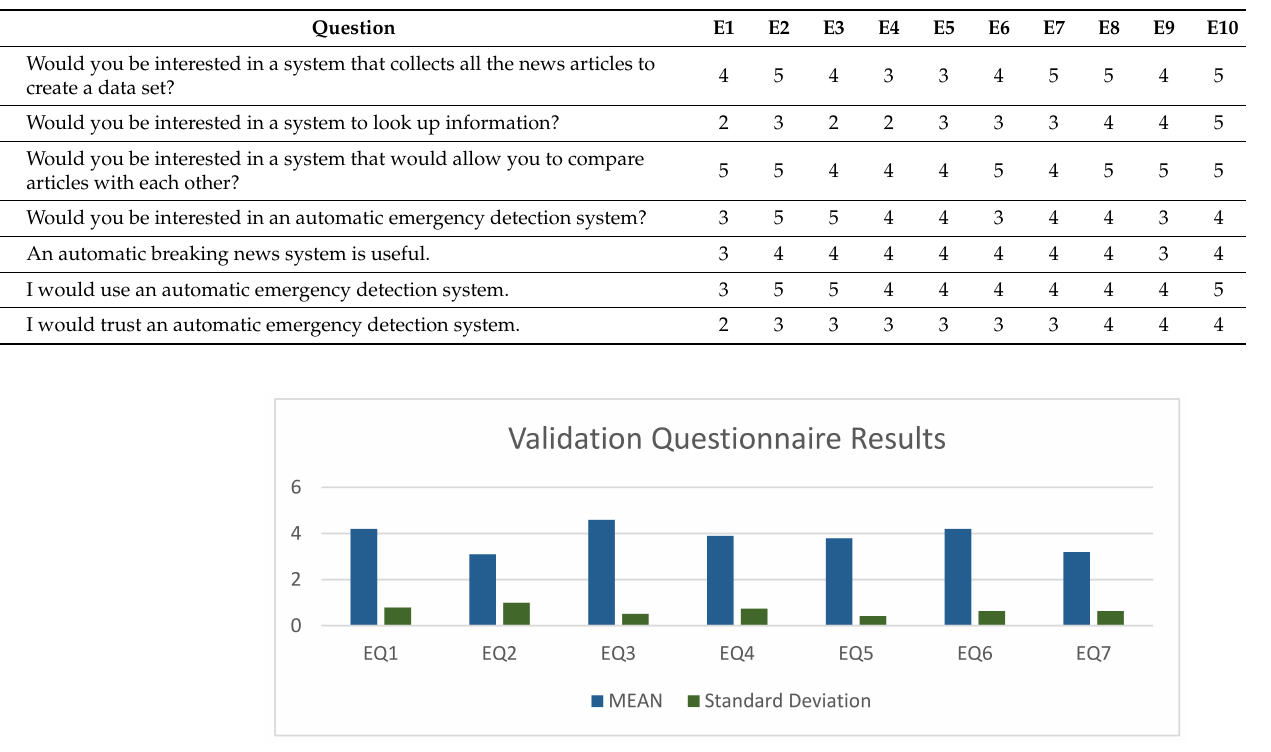
Figure 6. Mean and standard deviation of the answers given in the validation